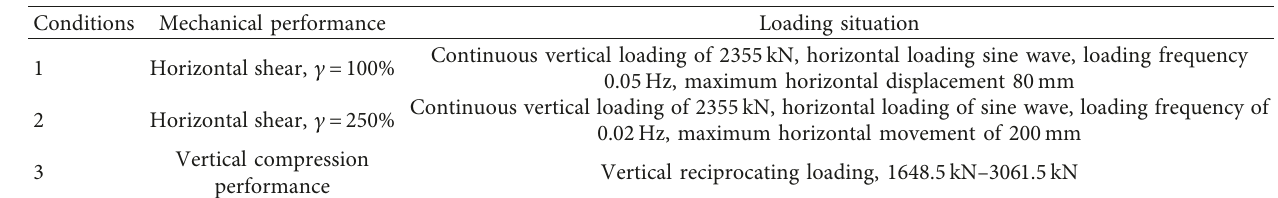
Table 2: Test conditions.